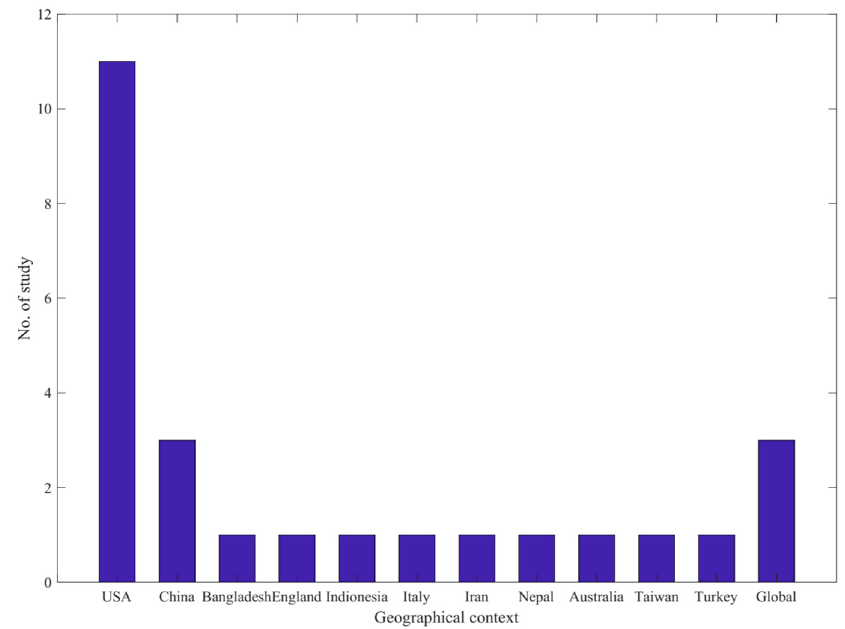
Figure 6. The geographic scope of the infrastructure resilience frameworks evaluated.